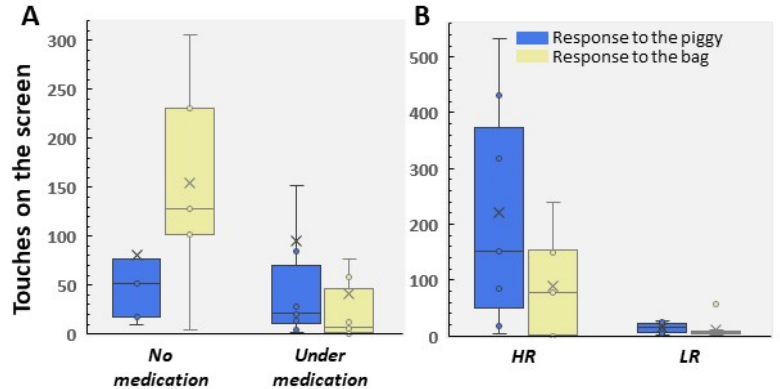
Figure 9. Mean of touches to the piggy and to the bag in the ADHD sample. Participants were distributed by ( A ) medical prescription and ( B ) HR/LR in patients on medical prescription.